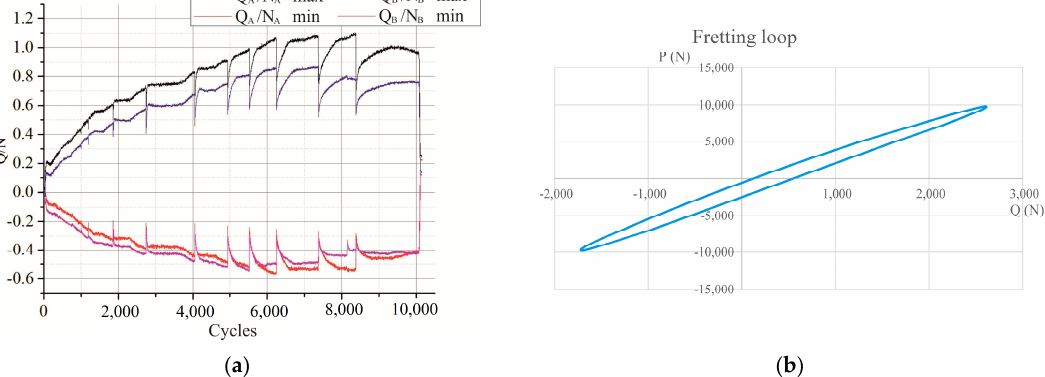
Figure 5. ( a ) Measurement of friction coefficient. ( b ) Fretting loop obtained in a test with load combination number 23.